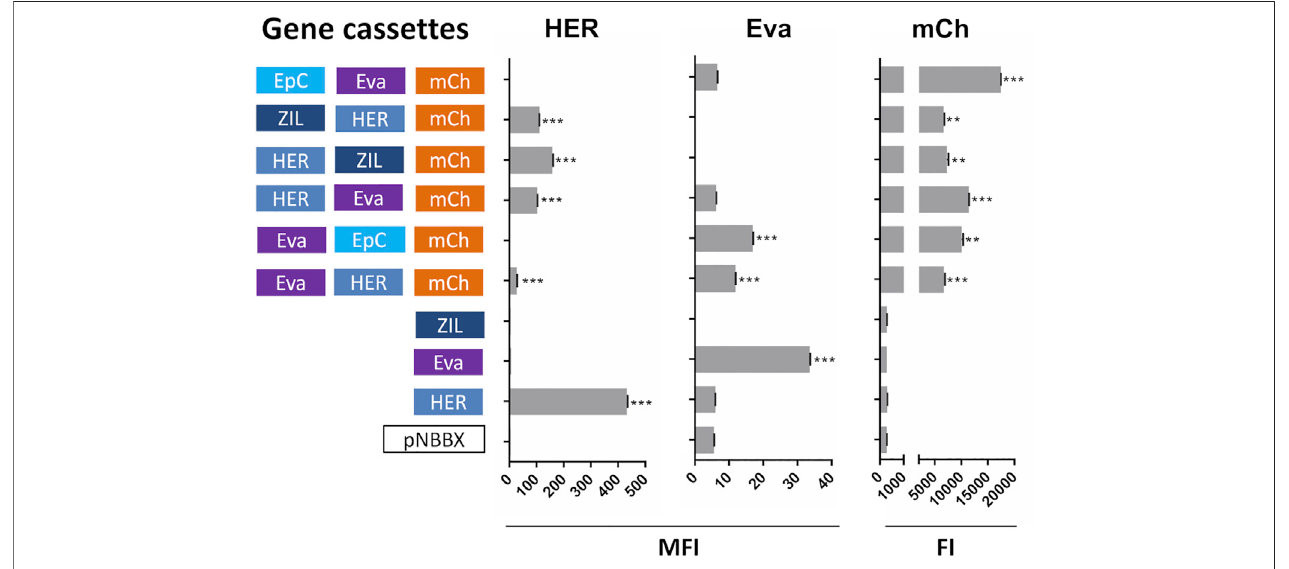
FIGURE 4 | Surface display of selected individual protein binders (cassettes HER and Eva), evaluated by fl ow cytometry (mean fl uorescence intensity, MFI), and expressionof fl uorescentproteinmCherry(cassettemCh);assessedbymeasuring fl uorescence( fl uorescenceintensity,FI)in L.lactis containingpNBBXderivativeswith up to three gene cassettes (denoted in 5 ′ -3 ′ direction). ** p < 0.001, *** p <